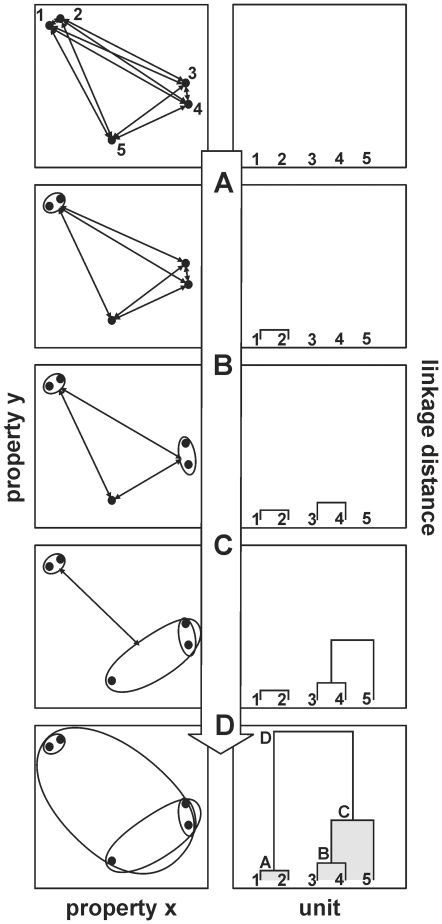
Schematic of aggregation procedure in hierarchical cluster analysis.
Left column: The position of single units in the n-dimensional space. In each step (A–D) units or groups of units with the smallest distance to each other are grouped together. Right column: The resulting developing dendrogram of the cluster analysis. The linkage distance indicates the similarity of the units. The higher the linkage distance the more differ the units in their properties.